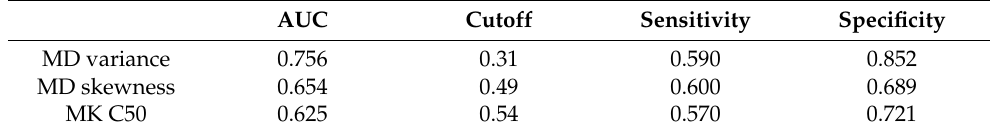
Table 4. ROC results of partial DKI histogram parameters.